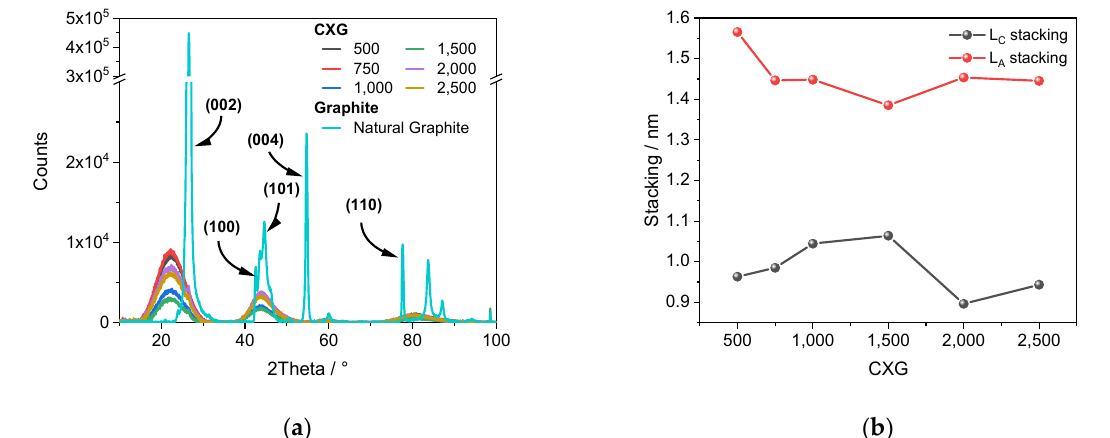
Figure 3. XRD diffractogram of selected CXG and natural graphite ( a ). Stacking width L A and stacking height L C of graphene crystallites as a function of R/C ratio during CXG synthesis ( b ). After synthesis and carbonization, the yielded carbons showed differences in density,